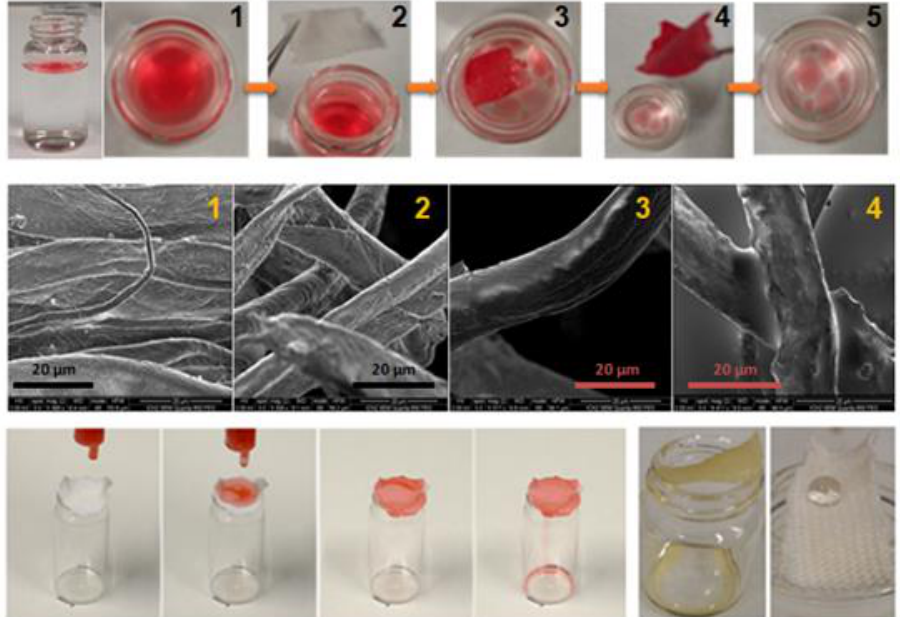
Figure 2. Top: Selective oil removal: ( 1 ) olive oil/water separation-phases; ( 2 – 5 ) soaking of a cotton@ P4b . Middle: SEM images of pristine cotton weaves ( 1 ), cotton@ P4b ( 2 ), and after absorption of TDC ( 3 ) and olive oil ( 4 ). Bottom: ( Left ) Sequence of an oil/water-phase separation by filtration with cotton@ P4b . Water phase is retained on the top, whereas oil phase (in red) passes through our household filter into the vial. ( Right ) Oil-phase saturation onto coated cotton weaves ( left ), and water-repellent character ( right ).